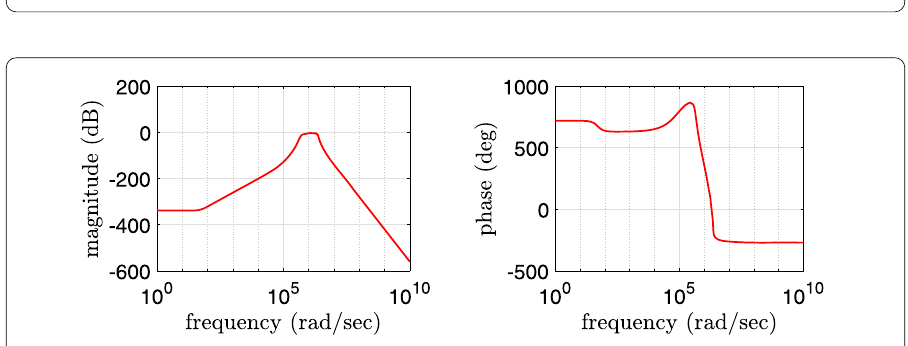
Figure 8 Bode plot of band-pass filter for a constant choice of the